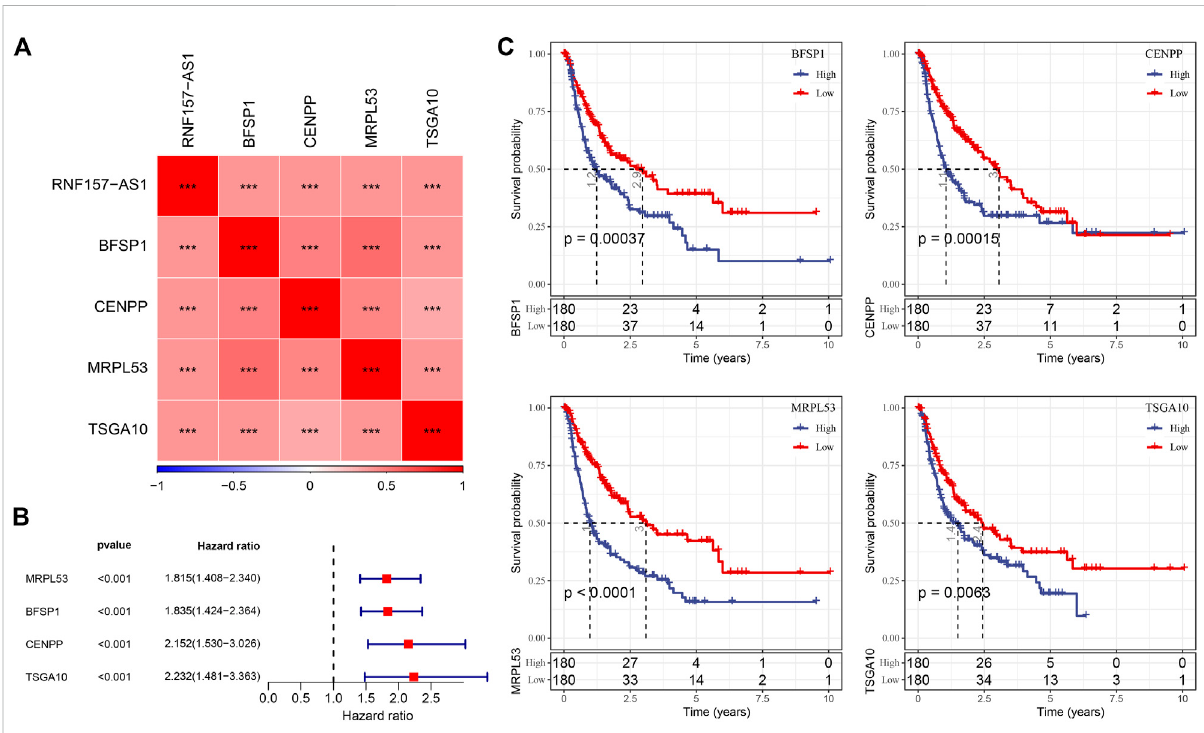
FIGURE 3 Relationship of RNF157-AS1 with four key PCGs and the association between four PCGs and HCC prognosis. (A) Pearson correlation analysis between the expression of RNF157-AS1 and four lncRNAs. Red and blue: positive and negative correlations, respectively. (B) Univariate Cox regression analysis of four lncRNAs. (C) Kaplan – Meier survival plots of high- and low-expression groups in the four lncRNAs. Log-rank tests were conducted. *** p <